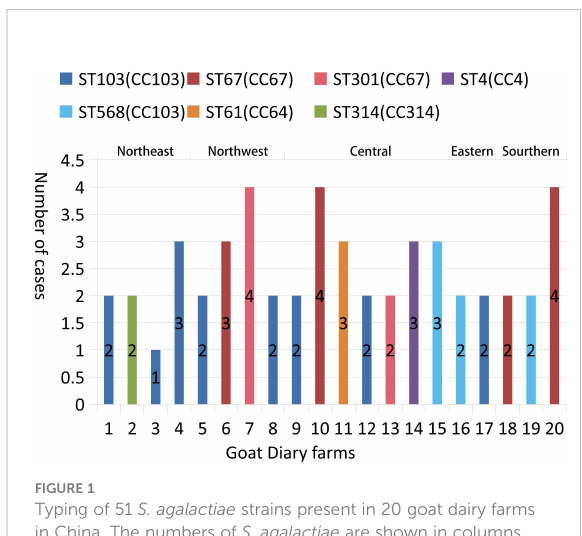
FIGURE 1 Typing of 51 S. agalactiae strains present in 20 goat dairy farms in China. The numbers of S. agalactiae are shown in columns. ST indicates the MLST sequence type; CC indicates the clonal